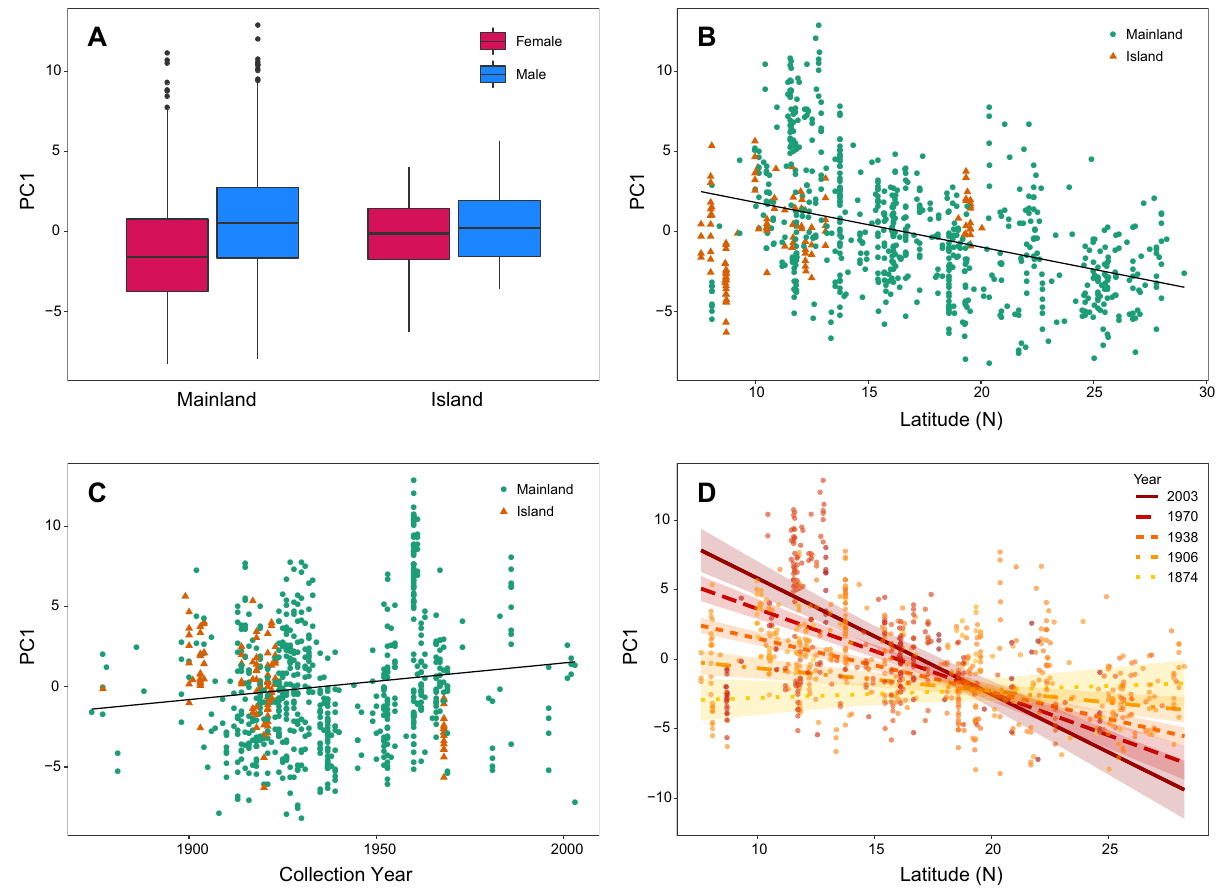
Figure 2. Spatial and temporal patterns in T. belangeri body size (Supplementary Table S2). ( A ) Box plots of females and males from the mainland and islands show mainland populations have a much greater degree of sexual size dimorphism than island populations, as suggested by a significant interaction between Sex and Source (Mainland/Island) in our model ( p < 0.05). ( B ) Linear relation between PC1 and Latitude shows that there is a reversal of Bergmann’s rule (decreasing body size with latitude) on the mainland ( p < 0.0001) , though the smaller island sample shows a slight increase at higher latitudes ( p < 0.0001). Consequently, Foster’s island rule may be upheld at higher latitudes (insular gigantism in these small mammals) more than at lower latitudes. ( C ) Linear relation between PC1 and Collection Year shows that there is a significant increase in size (PC1) throughout time ( p < 0.0001). ( D ) A plot depicting the positive interaction ( p < 0.0001) between Latitude and Collection Year in a linear model predicting body size (PC1). Regression lines, displayed at five evenly spaced intervals across the temporal range of the sample and plotted with 95% confidence intervals, indicate a reversal of Bergmann’s rule over